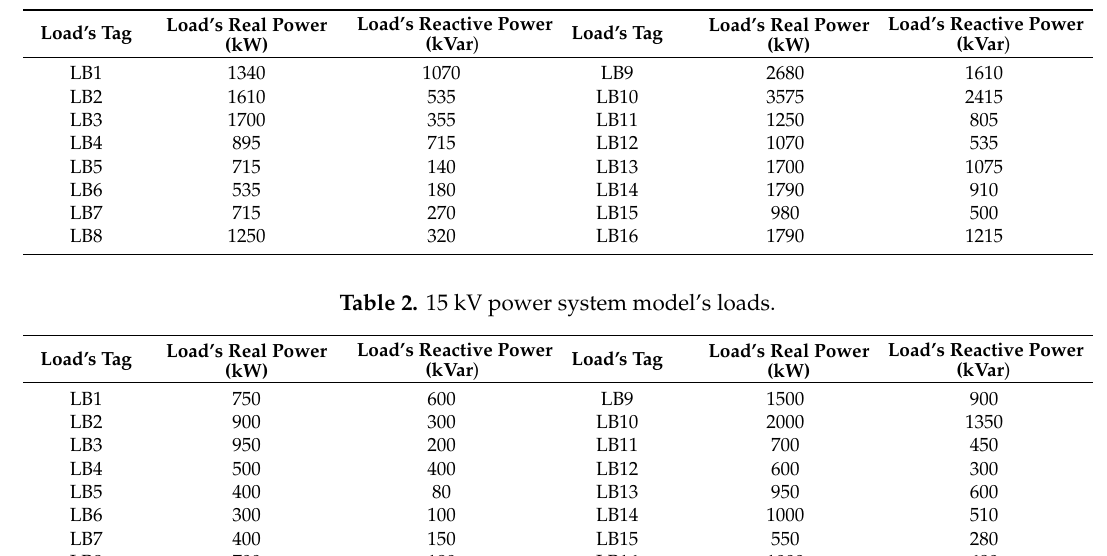
Table 1. 20 kV power system model’s loads.